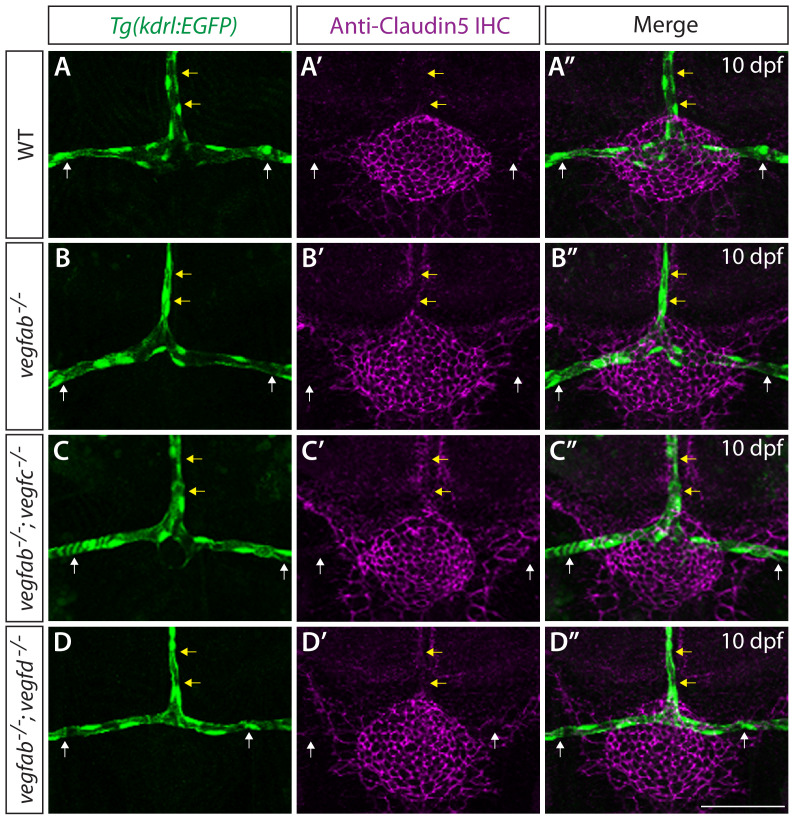
Analysis of Claudin-5 protein expression in the mCP vasculature of vegf single and double mutants.(A–D") Magnified views of 10 dpf WT (A–A"), vegfab-/- (B–B"), vegfab-/-;vegfc-/- (C–C"), and vegfab-/-;vegfd-/- (D–D") larvae carrying the Tg(kdrl:EGFP) transgene that were immunostained for GFP and Claudin-5 (magenta). In 10 WT fish, Claudin-5 immunoreactivity is prominent in mCP epithelial cells and weakly present in the tissues located ventrally to the DLV and PCeV but is barely detectable in the DLV and PCeV (A–A’). No obvious differences were observed in this low level of Claudin-5 expression in these vessels between WT and any of the vegfab-/-, vegfab-/-;vegfc-/-, and vegfab-/-;vegfd-/- larvae that formed these vessels (B–D"). Yellow arrows point to the DLV and white arrows to the PCeV. The number of the animals examined was: n = 65 for WT, n = 50 for vegfab-/-, n = 26 for vegfab-/-;vegfc-/-, and, n = 24 for vegfab-/-;vegfd-/- fish. Scale bar: 50 μm.